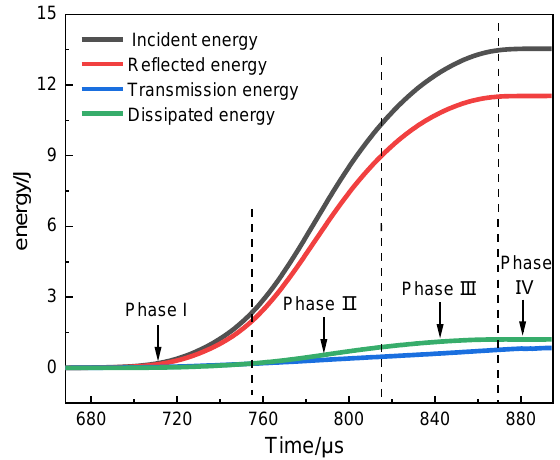
Figure 6. Typical energy vs. time curve.